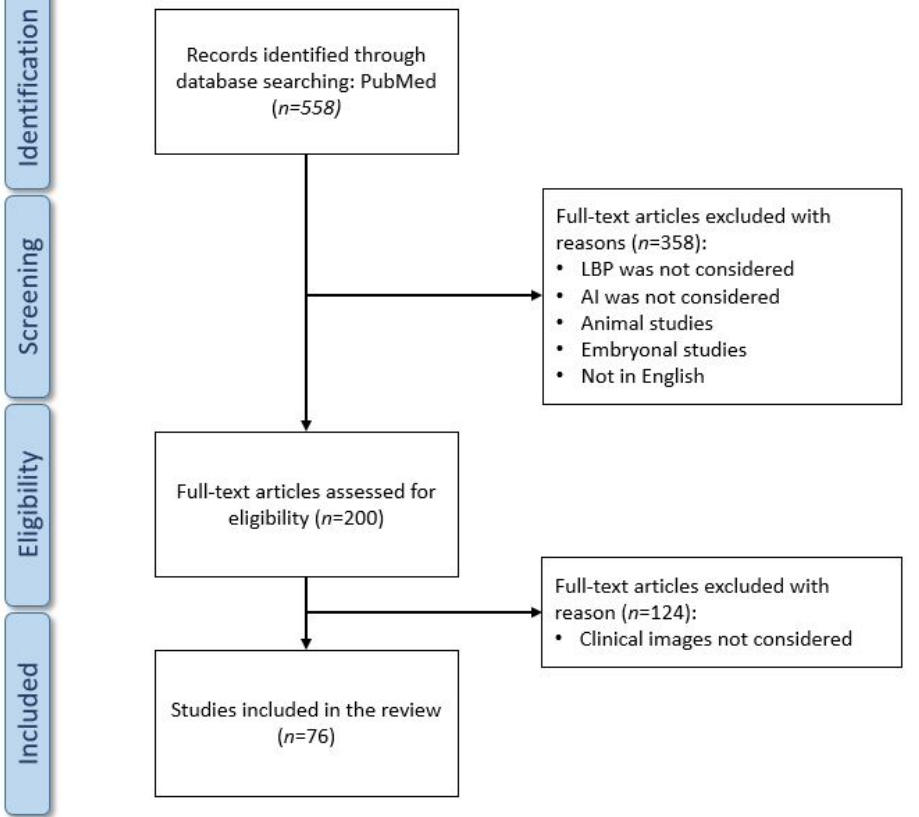
Figure 3. Preferred Reporting Items for Systematic reviews and Meta-Analyses (PRISMA) flow